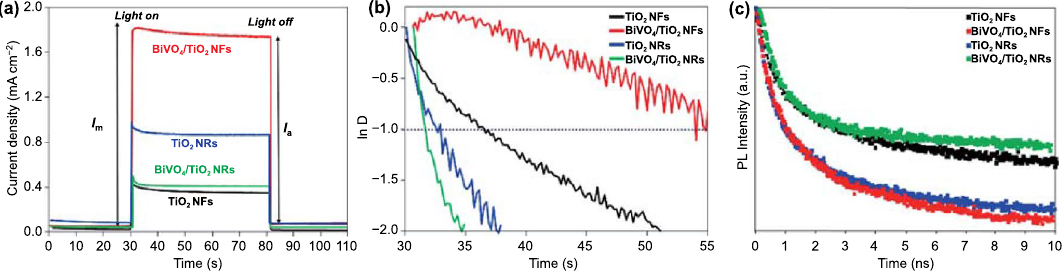
Fig. 5 a The transient photocurrent decay that occurs immediately upon illumination at 1.23 V (vs. RHE). b Transient decay times for TiO 2 NFs, TiO 2 NRs, BiVO 4 /TiO 2 NFs, and BiVO 4 /TiO 2 NRs. c TRPL of TiO 2 NFs, TiO 2 NRs, BiVO 4 /TiO 2 NFs and BiVO 4 /TiO 2